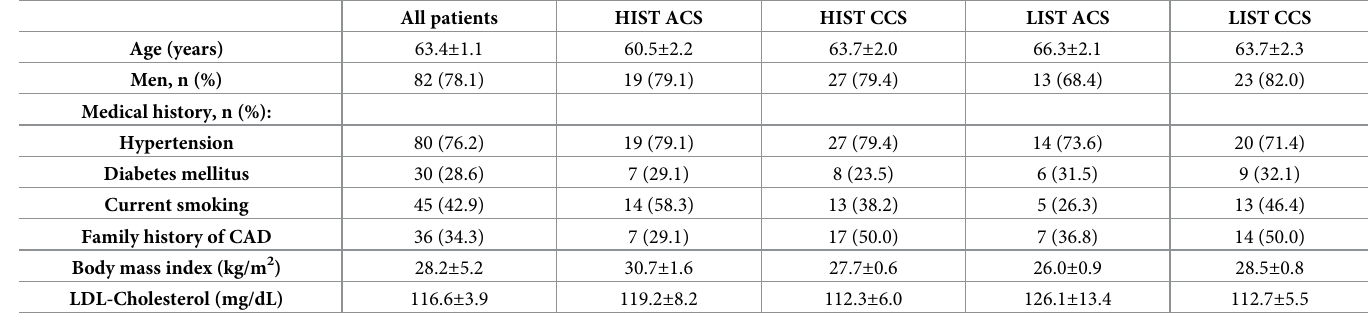
Table 1. Baseline clinical characteristics of patients.